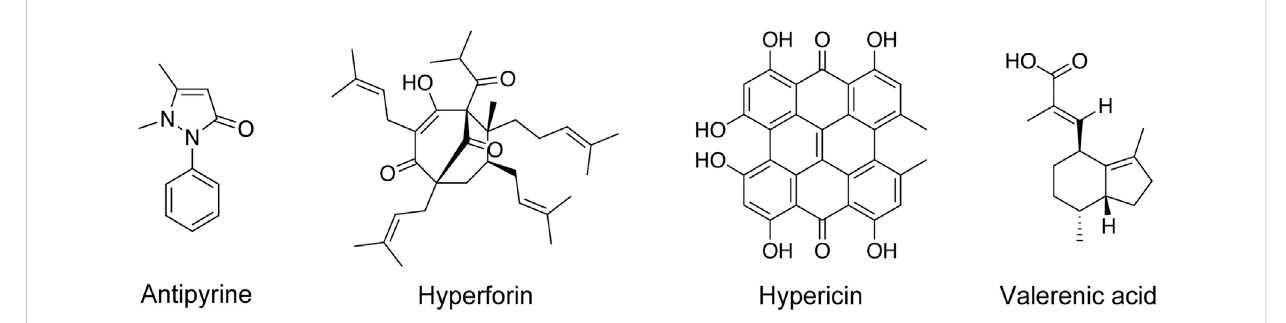
FIGURE 1 Chemical structures of investigated phytochemicals and